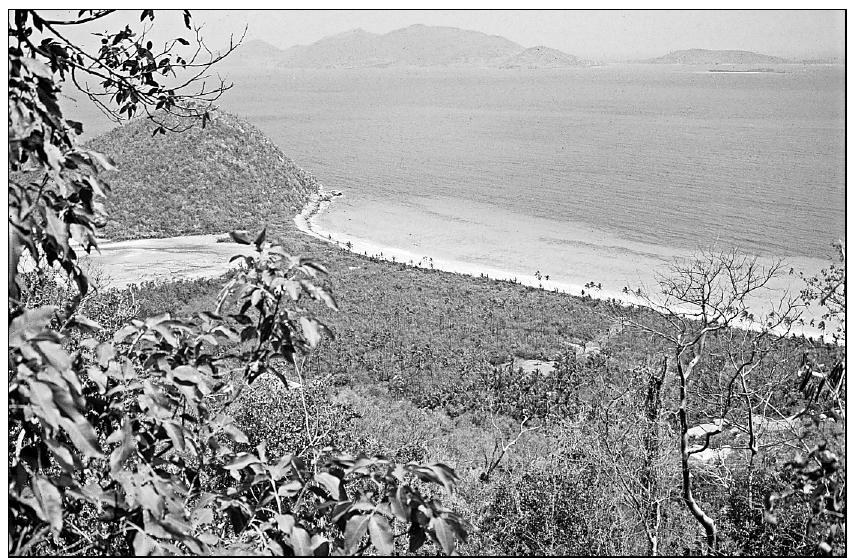
Figure 2 The Belmont settlement and ball-court site seen from the south; Belmont Hill and pond on the left.